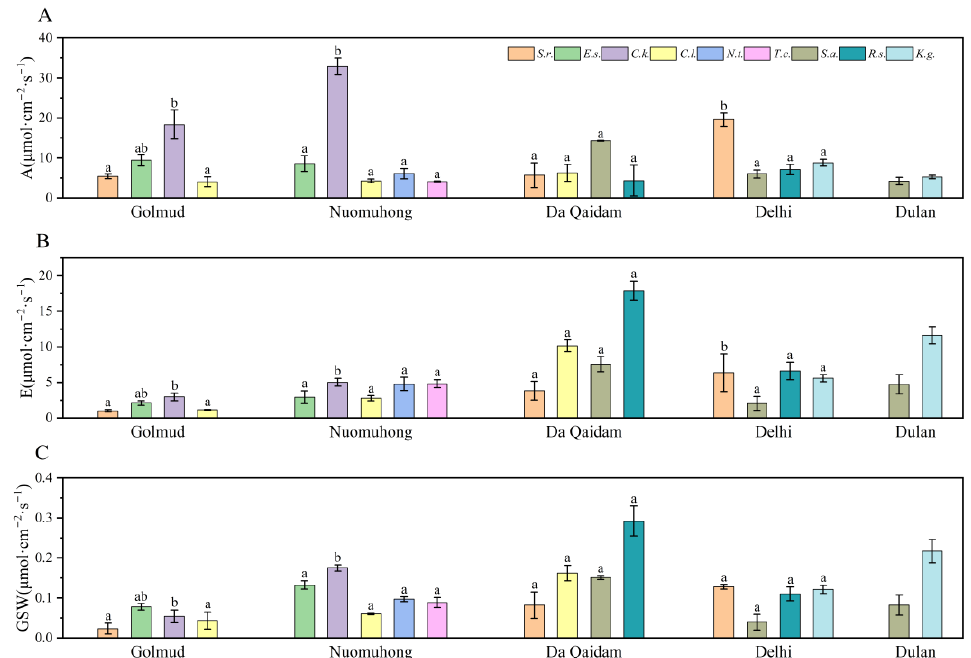
Figure 3. Leaf net photosynthetic rate (A, ( A )), transpiration rate (E, ( B )), and stomatal conductance (GSW, ( C )) among different species in the same community: the same lowercase letter indicates no significant difference among different species in the same community; different lowercase letters indicate significant differences among different species in the same community. The significance was at the p < 0.05 level. Species abbreviations were the same as Table 1.